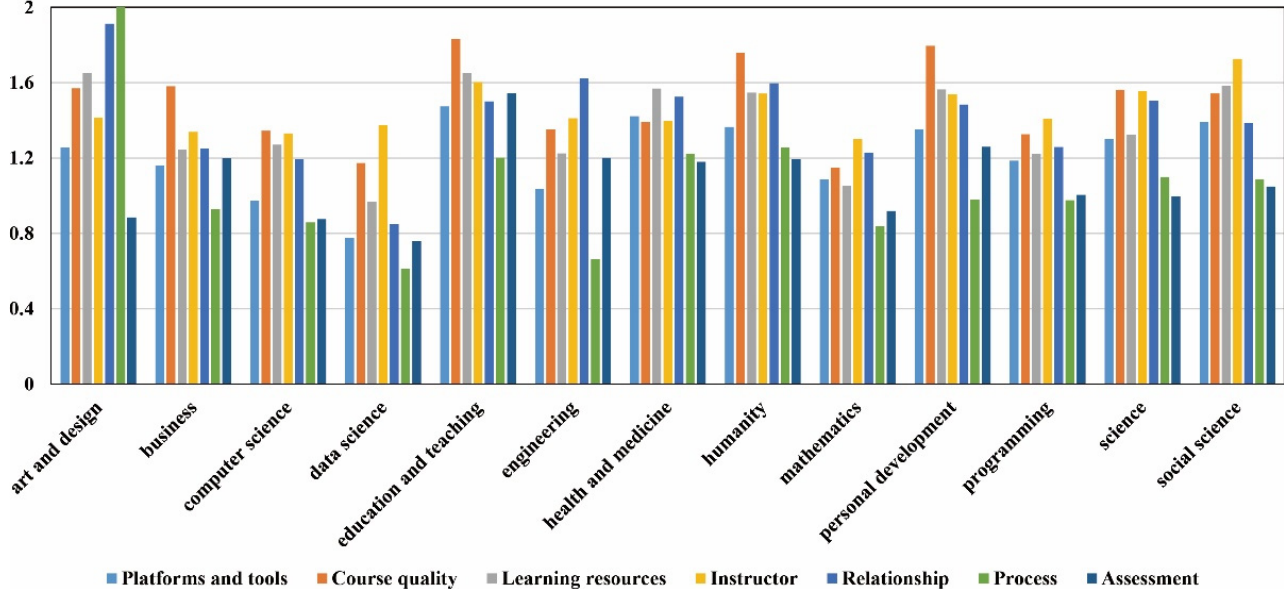
Figure 6. Averaged sentiment scores for each topic in different subjects (calculated based on “nrc”).